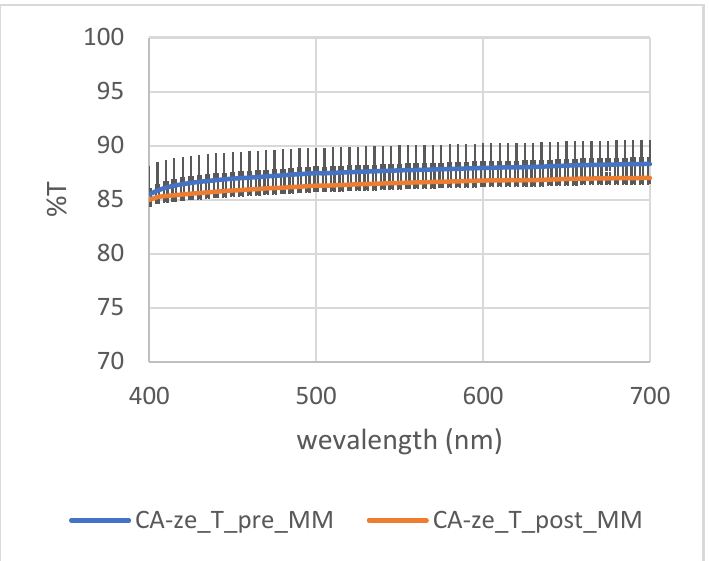
Figure 10. Transmittance values of the Zendura FLX with Carbon L1 printer analyzed before and after aging. The curves are the average of nine spectrophotometry values ± SD.